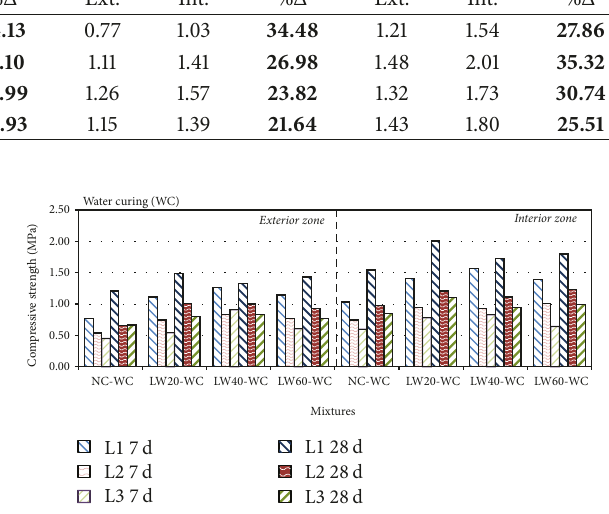
Figure 14: Minute compressive strength of NC and LWA mixtures at L1, L2, and L3 cured in the water (7 and 28 days of age).